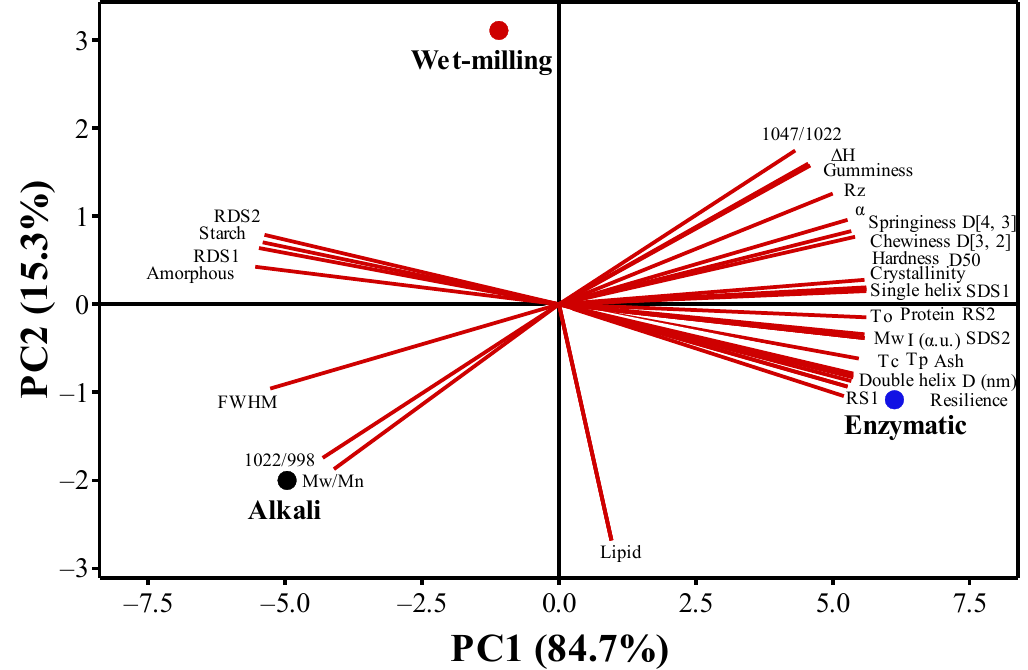
Figure 4. The PC1 and PC2 double dimensional plots of quinoa starch extracted by alkali, wet-milling, and enzymatic methods. Table 4. Principal component analysis score of quinoa starch extracted by alkali, wet-milling, and enzymatic method.